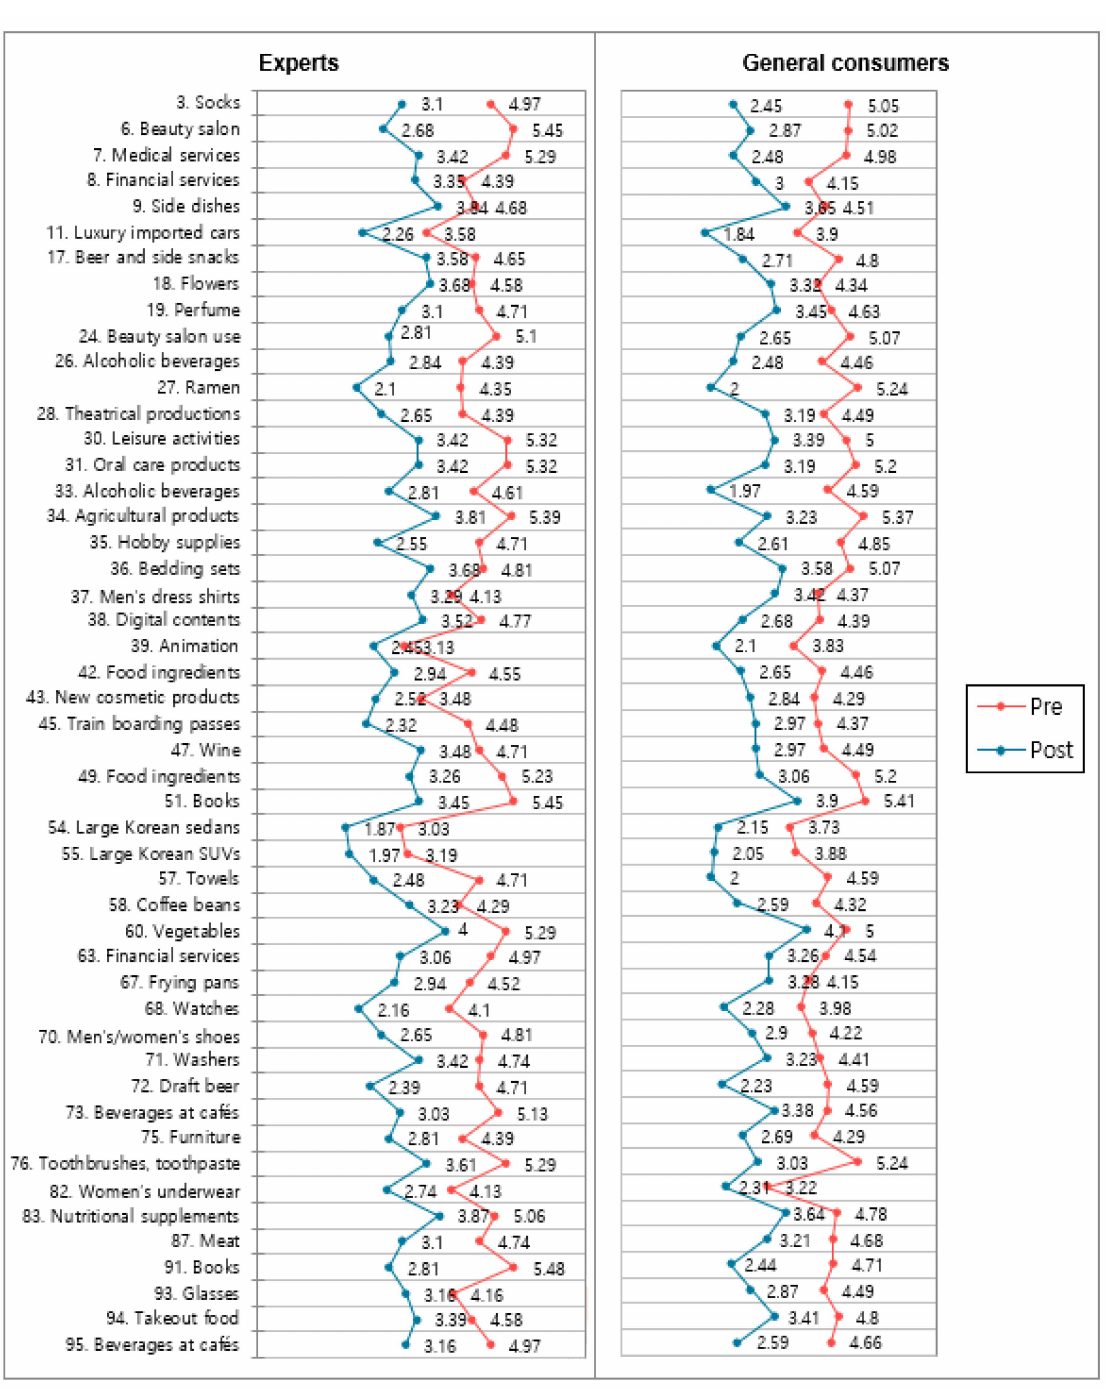
Figure 5. Items with significant t -test results in both experimental designs: purchase intention. Next, a multiple regression analysis was conducted using the consumption motiva- tion/quality inference data of the expert group as an independent variable and purchase intention as a dependent variable (Table